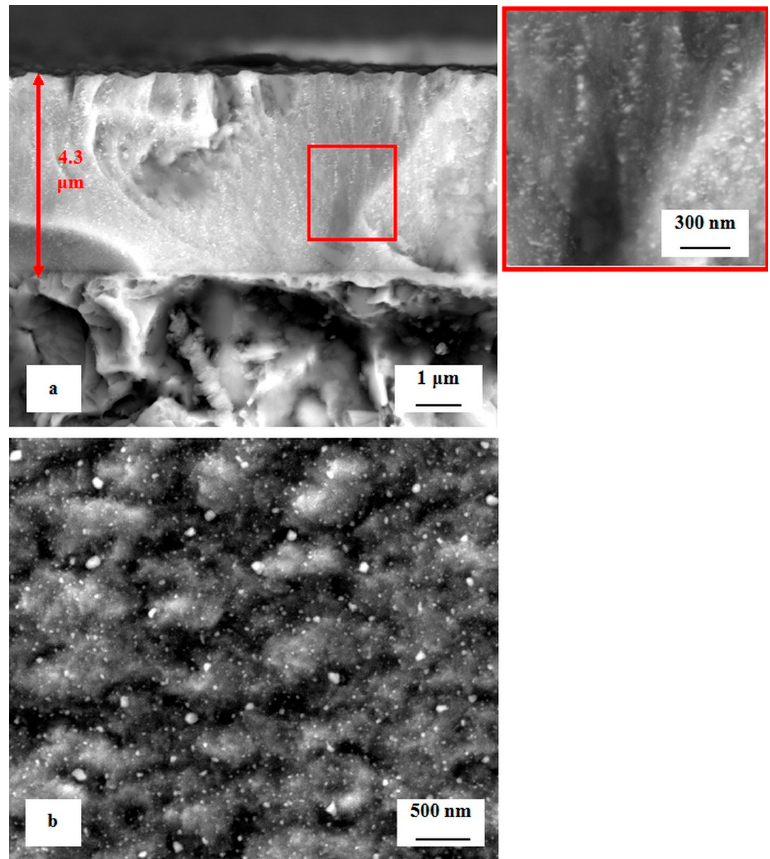
Figure 13. Microstructure of Cr 2 N–6Ag film deposited on the Vanadis 6 tool steel. ( a ) Cross-sectional SEM micrograph, overview, detail; ( b ) plan-view SEM micrograph.